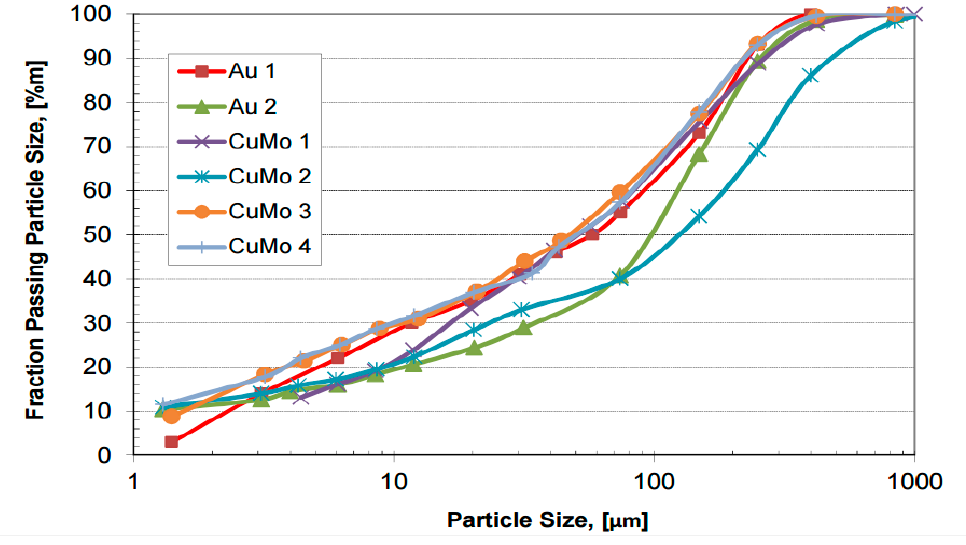
Figure 9. Typical granulometric curves of copper/molybdenum and gold mining tailings [54].